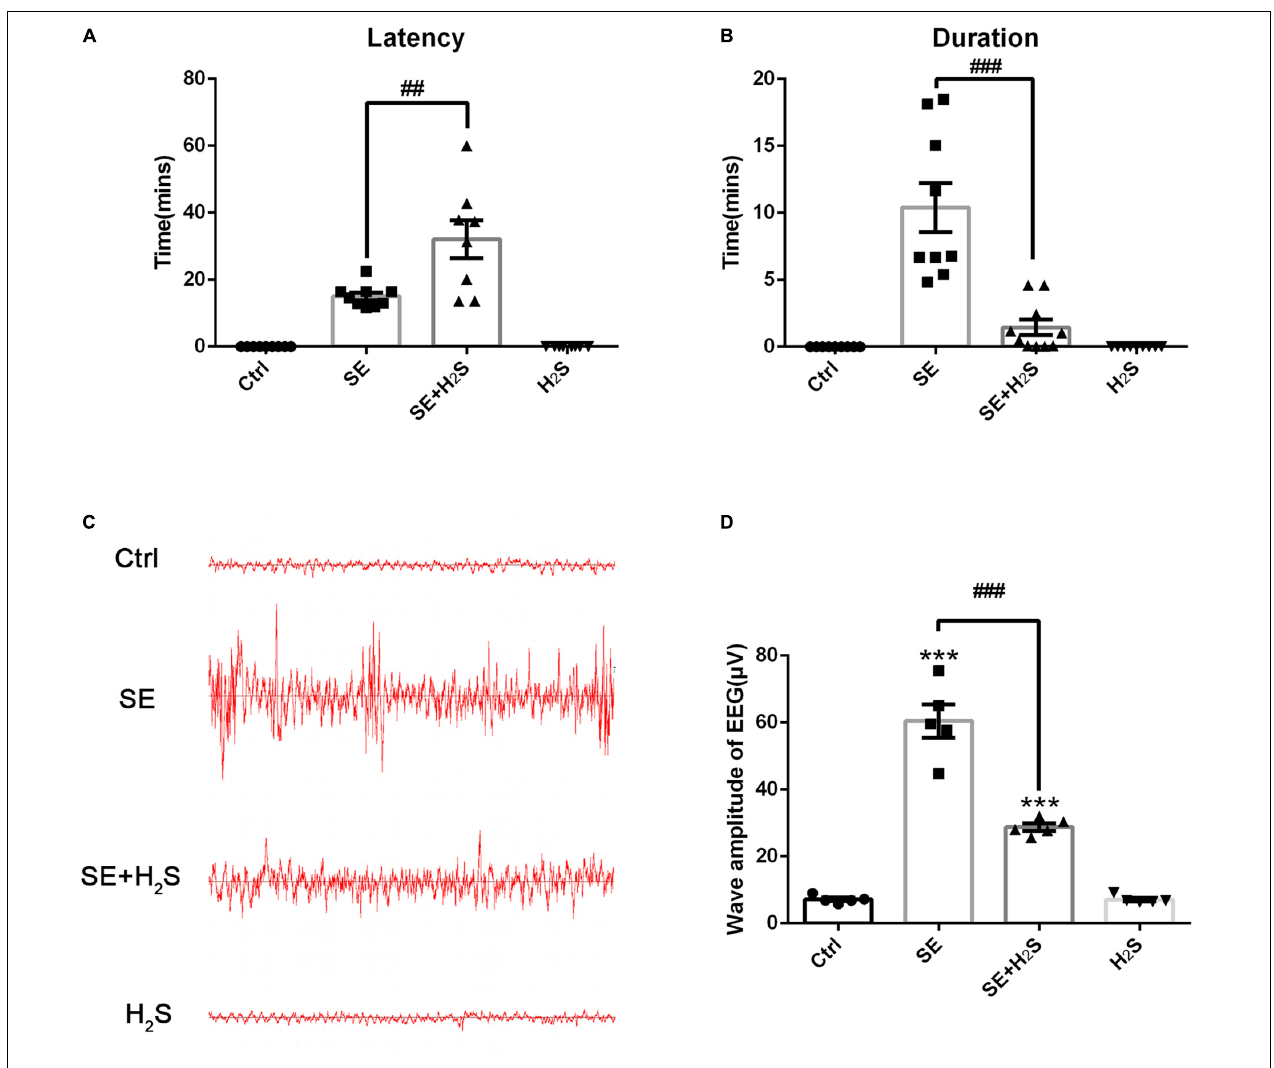
FIGURE 1 | The hydrogen sulfide (H 2 S) donor reduced seizure in a pilocarpine-induced mice model. (A) Status epilepticus (SE) mice treated with the H 2 S donor displayed a longer seizure latency. n = 9, 9, 8, and 9 for control, SE, SE+H 2 S, and H 2 S groups respectively. (B) The H 2 S donor shortened the duration of seizures in SE mice. n = 9, 9, 10, and 9 for control, SE, SE+H 2 S, and H 2 S groups respectively. (C) Representative EEG waves in mice of each group. (D) Statistics data of wave amplitude of electroencephalography (EEG) in different groups. SE mice showed increased wave amplitude of EEG, which was significantly reduced by the H 2 S donor administration. n = 5 per group. The results are expressed as the mean ± SEM. *** p < 0.001 vs Control, ## p < 0.01, ### p < 0.001 vs SE. One-way ANOVA with Bonferroni post hoc